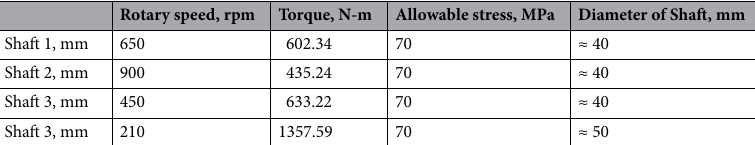
Table 3. Diameter of both straw chopper and incorporator shafts.